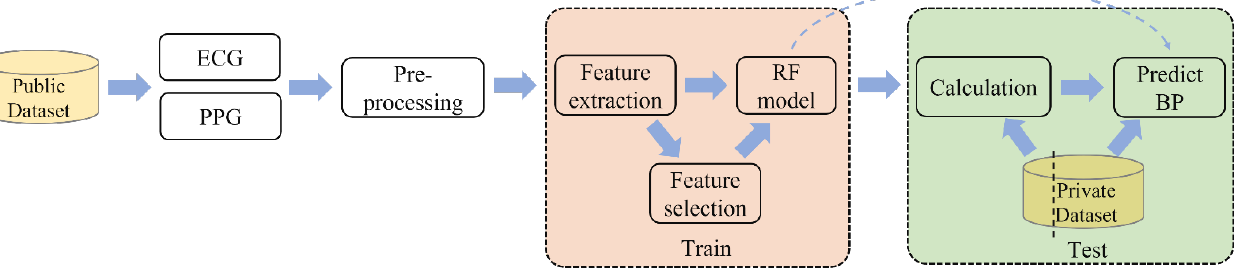
Figure 4. Block diagram of the proposed method.